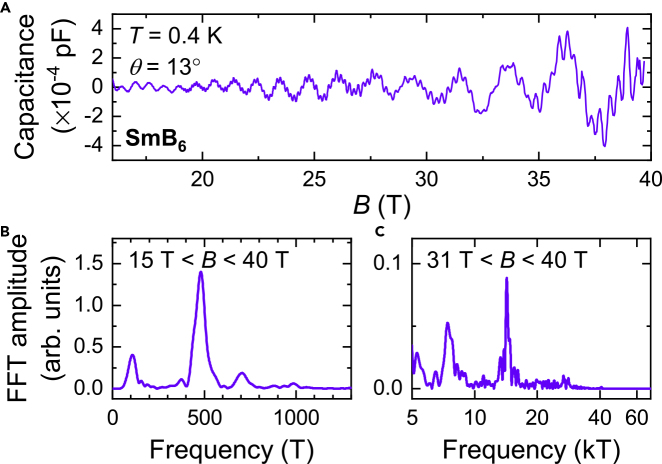
Magnetic Torque Quantum Oscillations in Pristine Floating-Zone Grown SmB6 Single Crystals(A) Quantum oscillations in the magnetic torque of floating zone-grown SmB6 single crystals measured in this study as a function of magnetic field. The field is aligned 16° from the [001] direction in the [001]-[111]-[110] rotational plane.(B and C) Fourier transforms of the measured magnetic torque as a function of inverse magnetic field in the field ranges (B) 15 T < B < 40 T and (C) 31 T < B < 40 T, revealing a wide range of quantum oscillation frequencies ranging from 300 T to 15 kT, similar to our previous study in Tan et al. (2015). A higher magnetic field window is used to reveal the high frequency oscillations corresponding to the α, λ and ξ branches identified in Figure 7A.